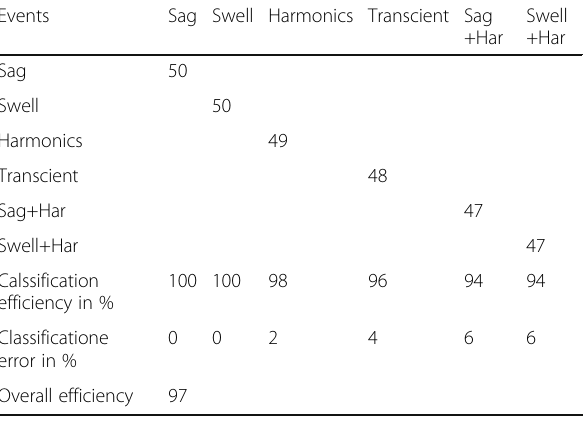
Table 2 Classification results under ideal signal condition